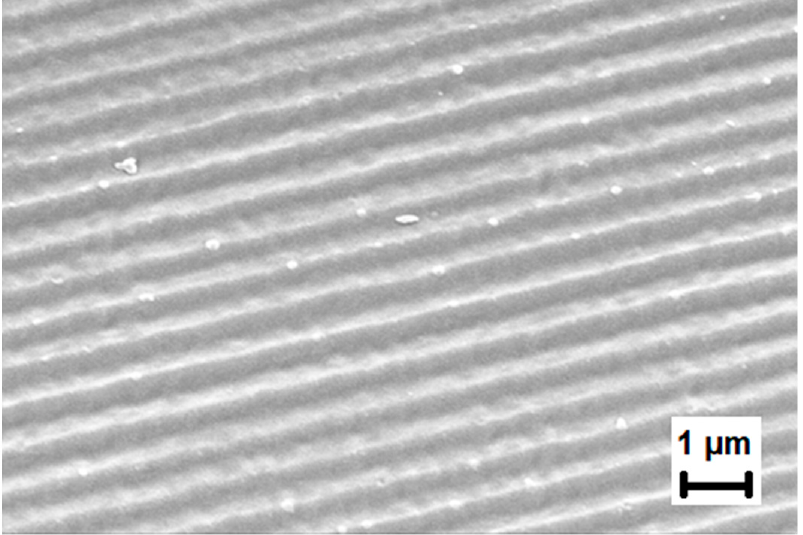
Figure 5. SEM image of the cleaned SiO x surface of sample “H”. To avoid charging during SEM inspection, the sample was homogeneously coated with 20 nm of gold. The laser irradiation results in a sine-shape line grating with a period of 594 ± 16 nm. Laser parameters: λ = 193 nm, 1 pulse, 640 mJ/cm 2 , (fluence averaged over entire area). SEM parameters: 0 ◦ observation angle; 20 kV; 5.5 mm Working Distance.